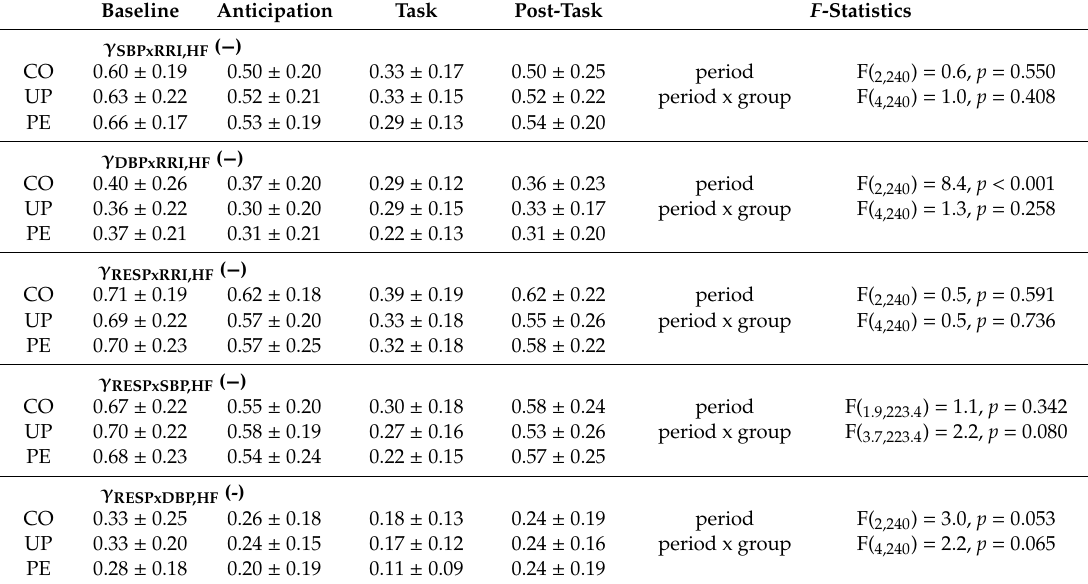
Table 4. Phase synchronization indices of the high-frequency (HF) components (mean ± SD) of participants, and statistical results for group di ff erences in response to the stress manipulation. CO: women without gestation during the last three years; UP: women with uncomplicated pregnancies;